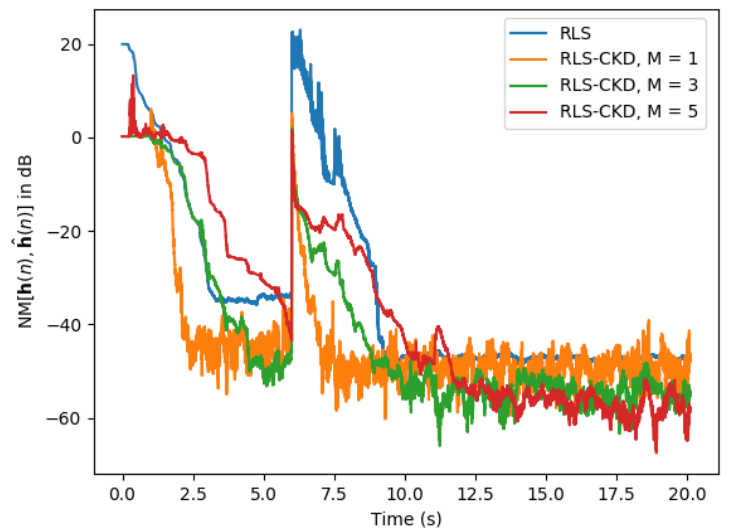
Figure 13. Normalized misalignment of the classical RLS ( L = 2048) and RLS-CKD ( L 1 = 64, L 2 = 8, L 3 = 4) algorithms. The input signal is a speech sequence and the impulse response changes after 6